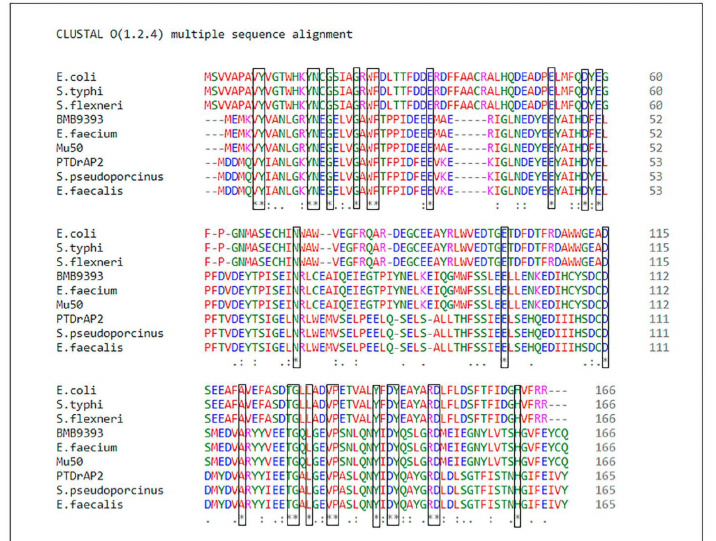
Figure 2. Alignment of ArdA-H amino acid sequences of different Gram-positive and Gram- negative bacteria. E. coli: E. coli strain SE11 (Acc: B6IC30); S. typhi: Salmonella typhimurium strain 4/74 (Acc: E8XLS4); S. flexneri: Shigella flexneri (Acc: A0A2A2XIH3); BMB9393: MRSA strain BMB9393 (Acc: WP_000425404); E. faecium: E. faecium ISMMS_VRE_11 (Acc: